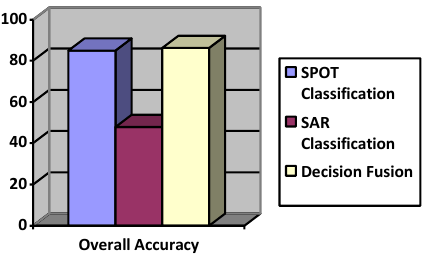
Figure 5. Comparing overall accuracies of the classification maps and decision fusion of